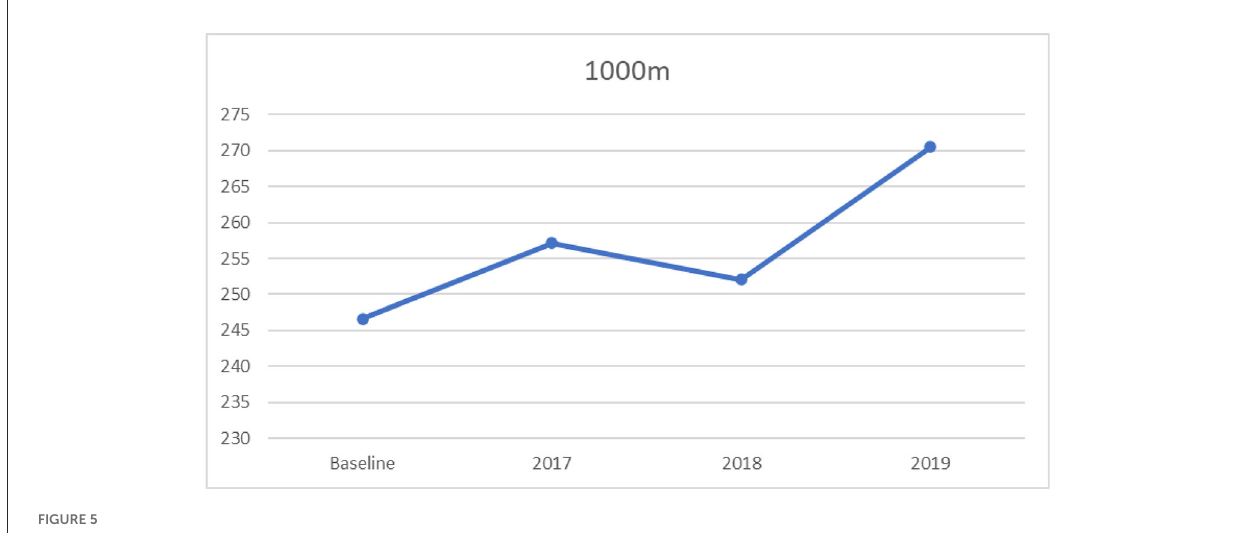
FIGURE5 Mean 1,000m run scores: across baseline and years 2017–2019.